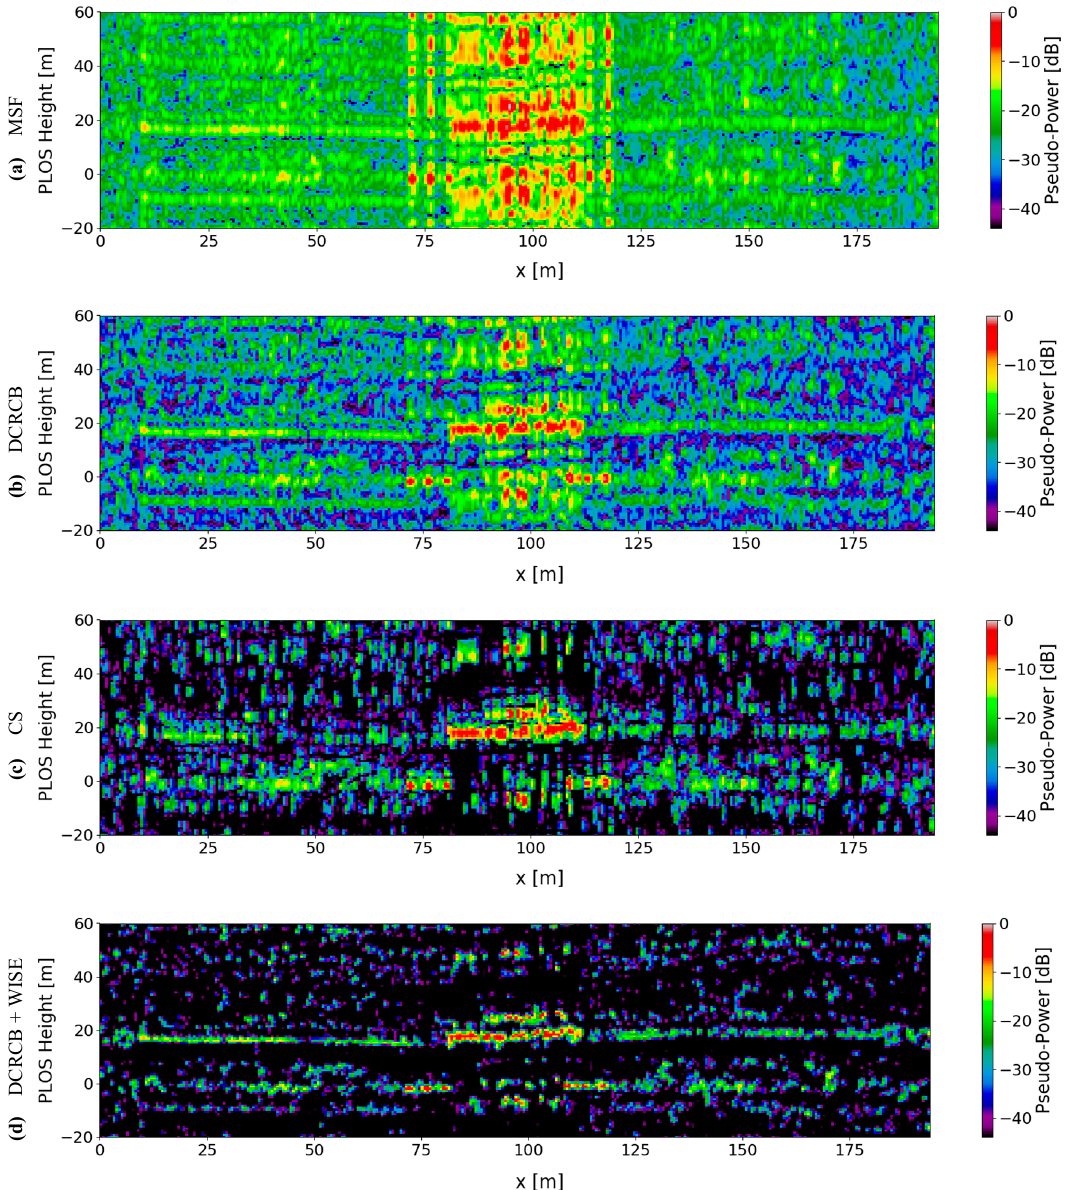
Figure 15. HH tomograms retrieved from the area depicted by the red line crossing the ROI specified in Figure 5. We perform focusing using ( a ) MSF, ( b ) DCRCB, ( c ) CS and ( d ) DCRCB + WISE. We refer to the single-look case. All tomograms are normalized with respect to the (pseudo) power recovered by MSF.